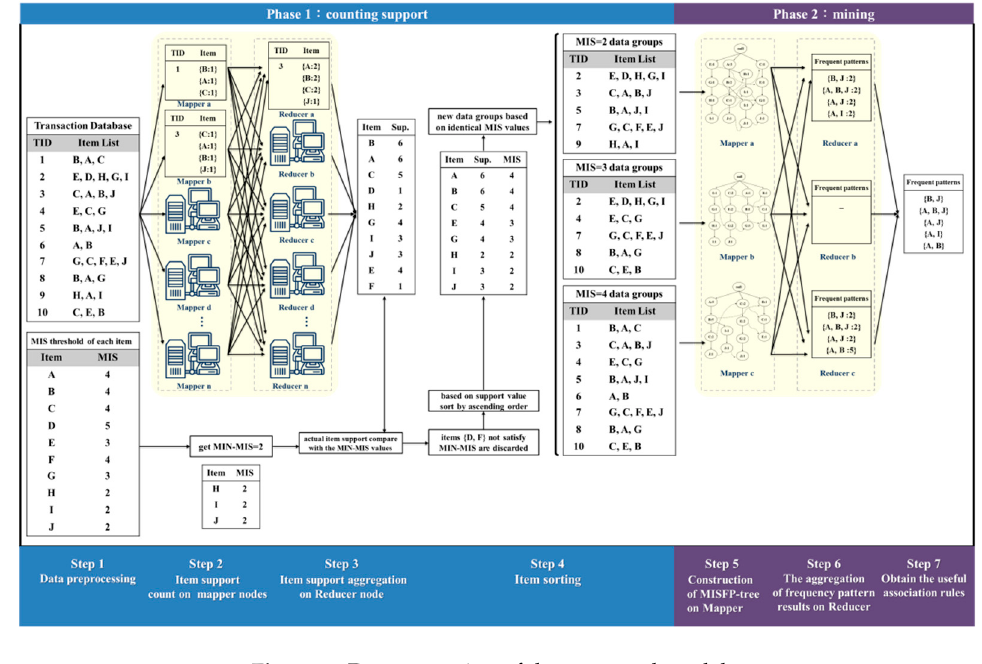
Figure 3. Demonstration of the proposed model.